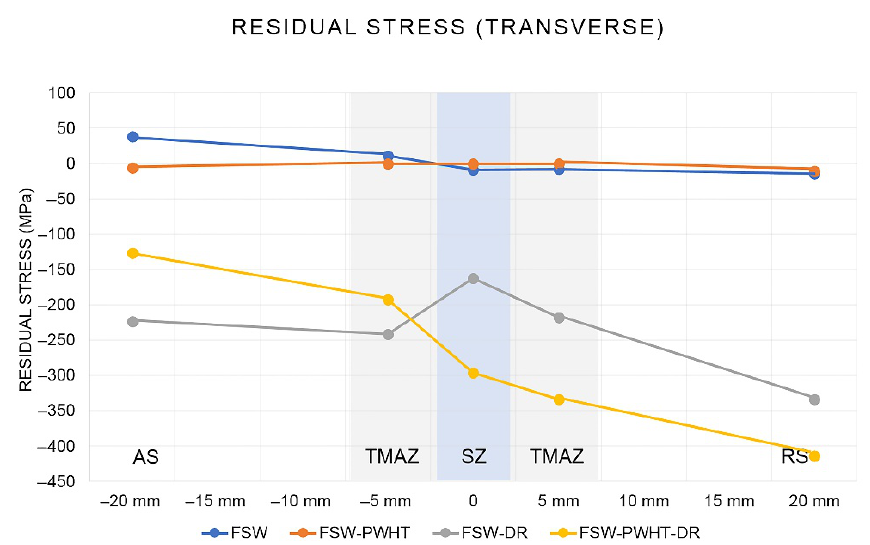
Figure 17. Residual stress measurement for each point: ( a ) transverse direction and ( b ) longitudinal direction .